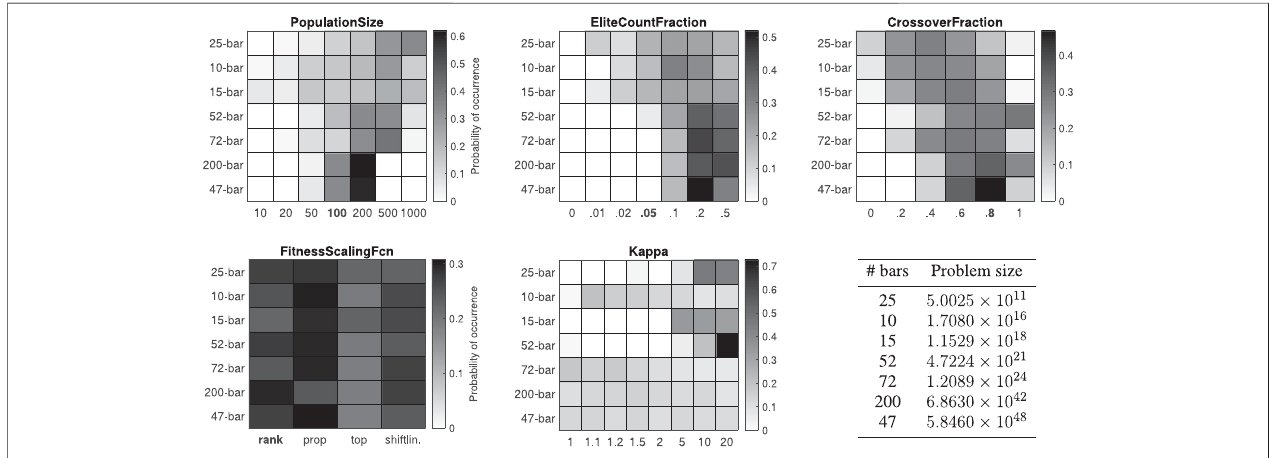
FIGURE8| Comparisonofthetop1%parametervaluedistributionsforalloptimizationproblemsinthetestset.Theresultsareorderedaccordingtothenumberof discrete solutions in the design space (the problem size).